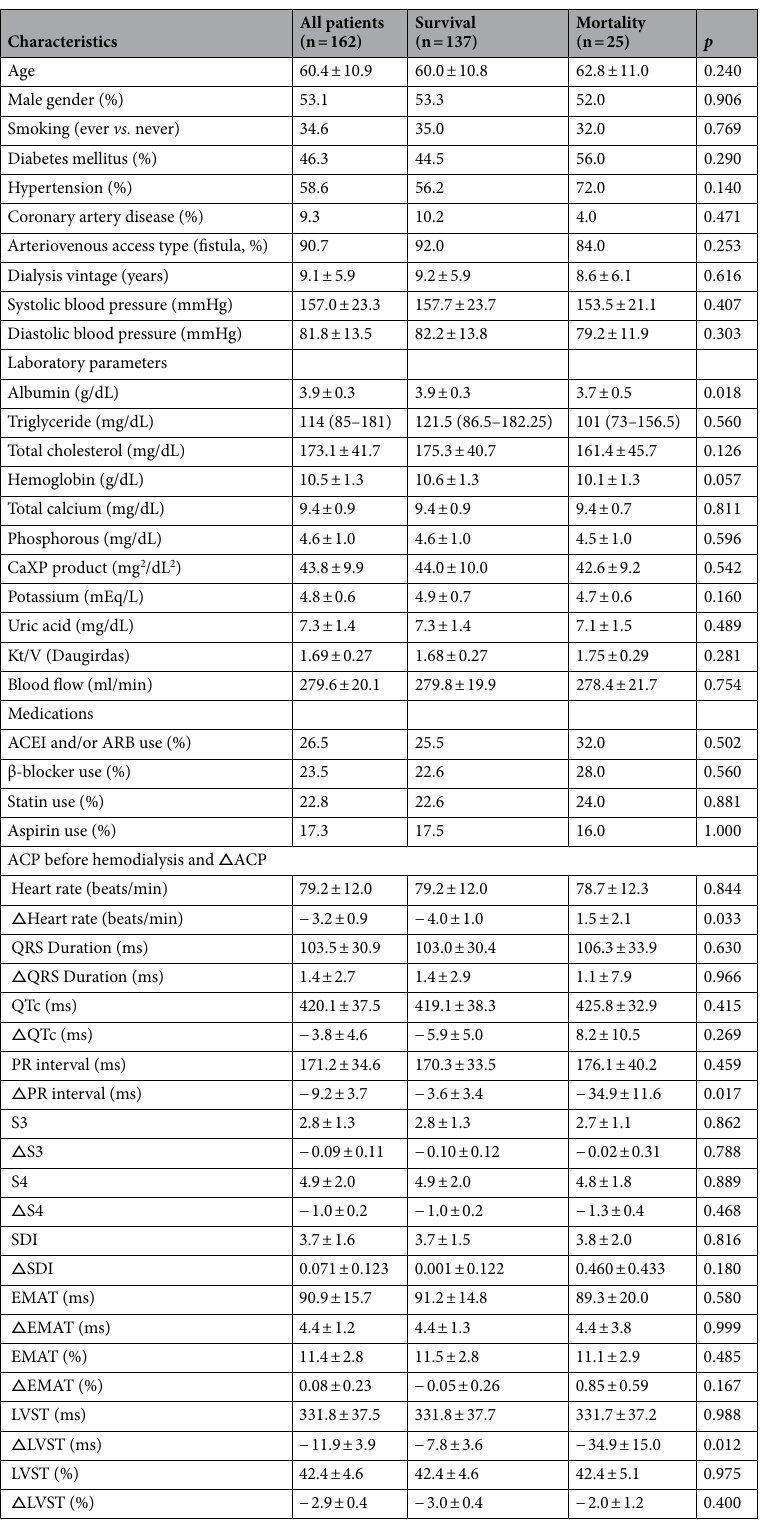
Table 1. Comparison of baseline characteristics in patients categorized by survival and mortality. Abbreviation: CaXP product, calcium × phosphorus product; ACEI, angiotensin converting enzyme inhibitor; ARB, angiotensin II receptor blocker; ACP, acoustic cardiography parameters; SDI, Systolic dysfunction index; EMAT, Electromechanical activation time; LVST, LV systolic